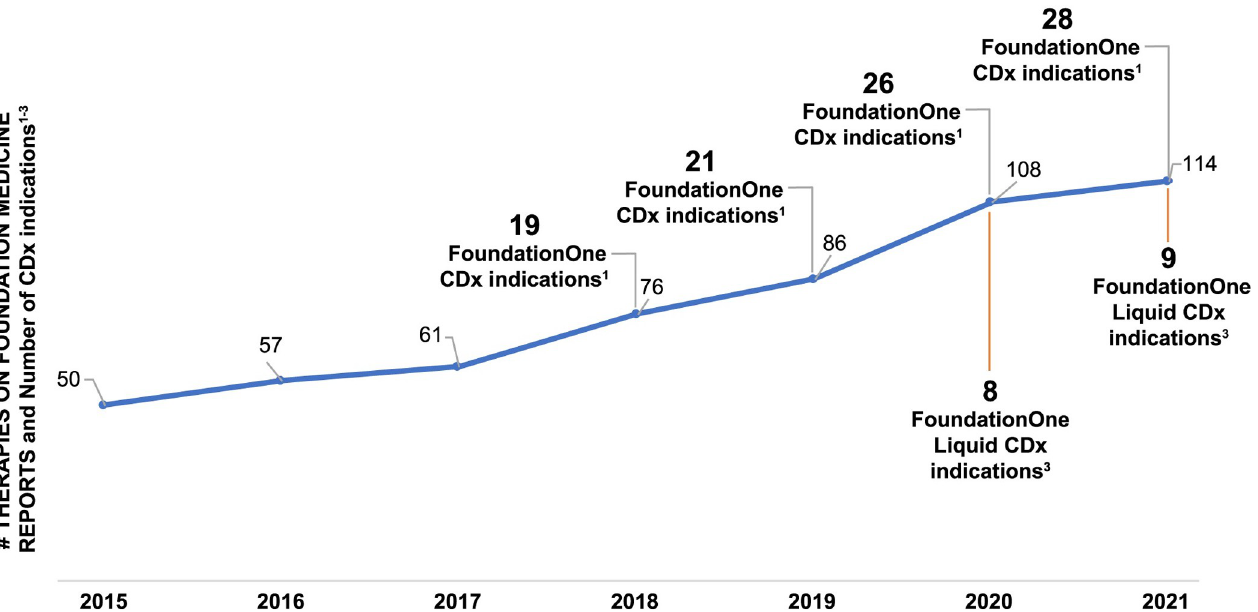
Fig 5. Growth and evolution of precision medicine therapies and companion diagnostic biomarkers over time, as demonstrated by increasing number of approved therapies included on Foundation Medicine test results and increasing number of companion diagnostic indications and biomarkers. 1 FoundationOne 1 CDx. Technical Information. Foundation Medicine, Inc; 2020. www.F1CDxLabel.com. 2 Data on File, Foundation Medicine, Inc., 2021. 3 FoundationOne 1 Liquid CDx. Technical Information. Foundation Medicine, Inc; 2020. www.F1LCDxLabel.com. Updated July 26, 2021. CDx = companion